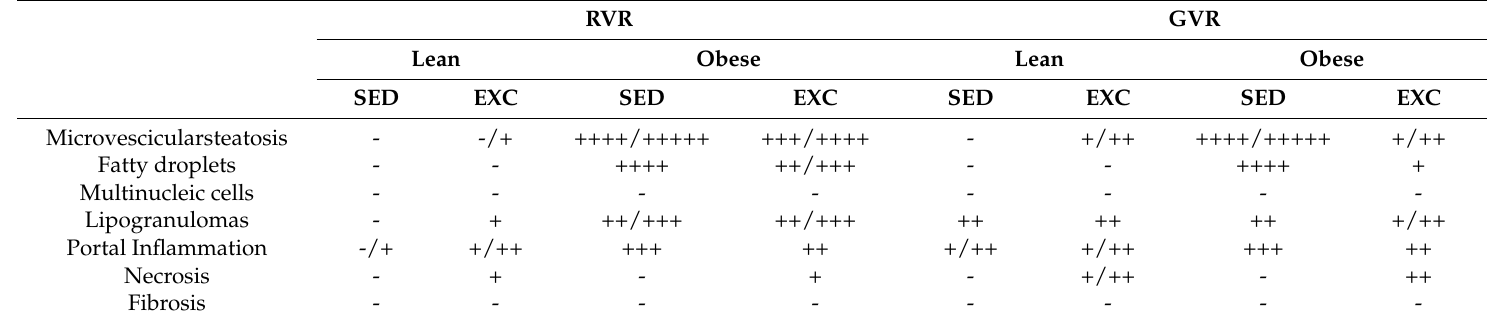
Table 6. Effect of phenotype, diet, and aerobic interval training protocol on liver histology of Zucker rats. RVR GVR Lean Obese Lean Obese SED EXC